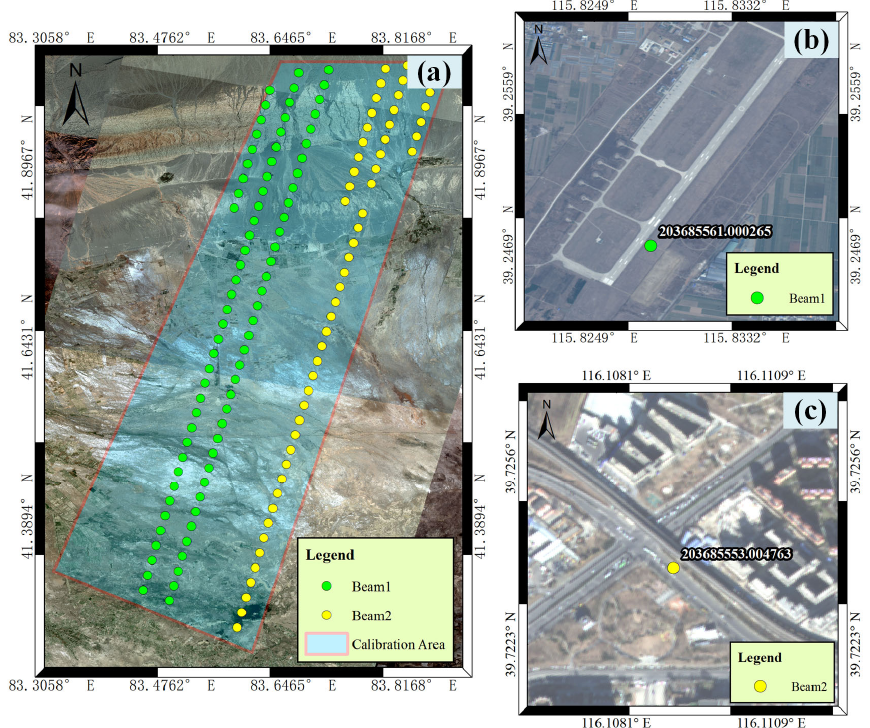
Figure 1. The laser calibration area and GF ‐ 7 satellite laser calibration data distribution. ( a ) The GF ‐ 7 satellite laser pointing calibration area. ( b ) The GF ‐ 7 satellite laser beam 1 ranging calibration area. ( c ) The GF ‐ 7 satellite laser beam 2 ranging calibration area.